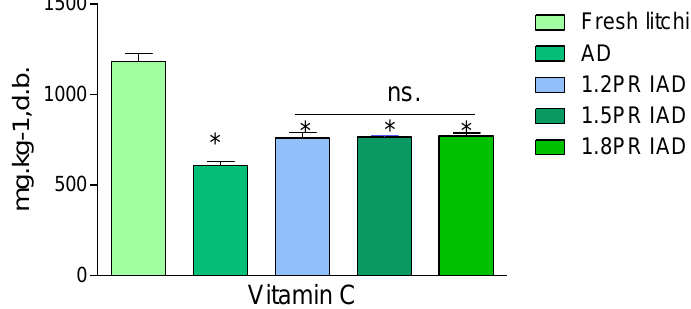
Figure 4. Vitamin C content of litchi dried by drying schemes with di ff erent pulse ratios. Note: AD is continuous air drying; the ratio 1.2 PR is an on 20 min and o ff 5 min pulse of intermittent air drying; the pulse ratio 1.5 PR is an on 20 min and o ff 10 min ratio of intermittent air drying; PR 1.8 is an on 20 min and o ff 15 min ratio; PR = [(on-drying time + o ff -drying time) / drying time] in one cycle; vitamin C value is the average value ± standard deviation; asterisk (*) is significantly di ff erent ( p < 0.05); n.s. is non-significant; d.b. is dried